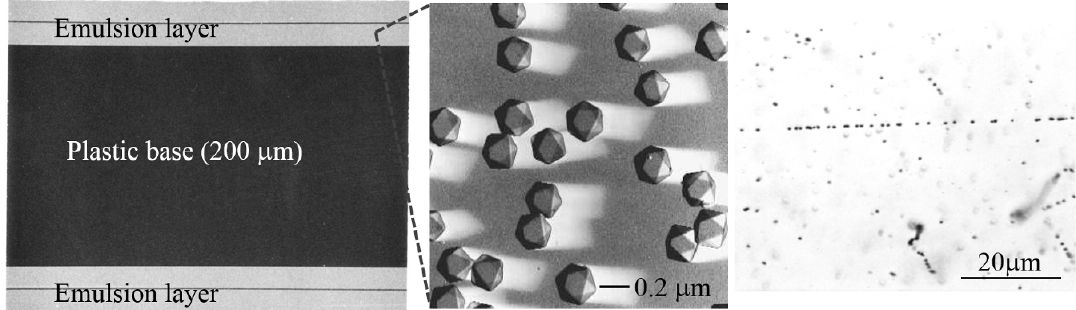
JHEP01(2020)033